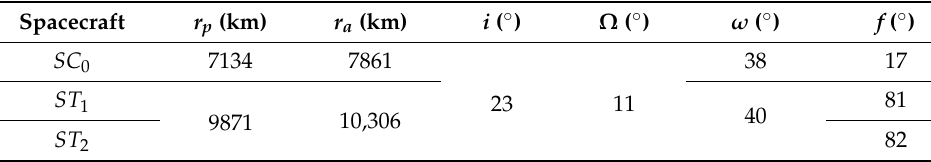
Figure 9. The minimum fuel solution of case 2. Table 2. Initial orbital elements of the problem.